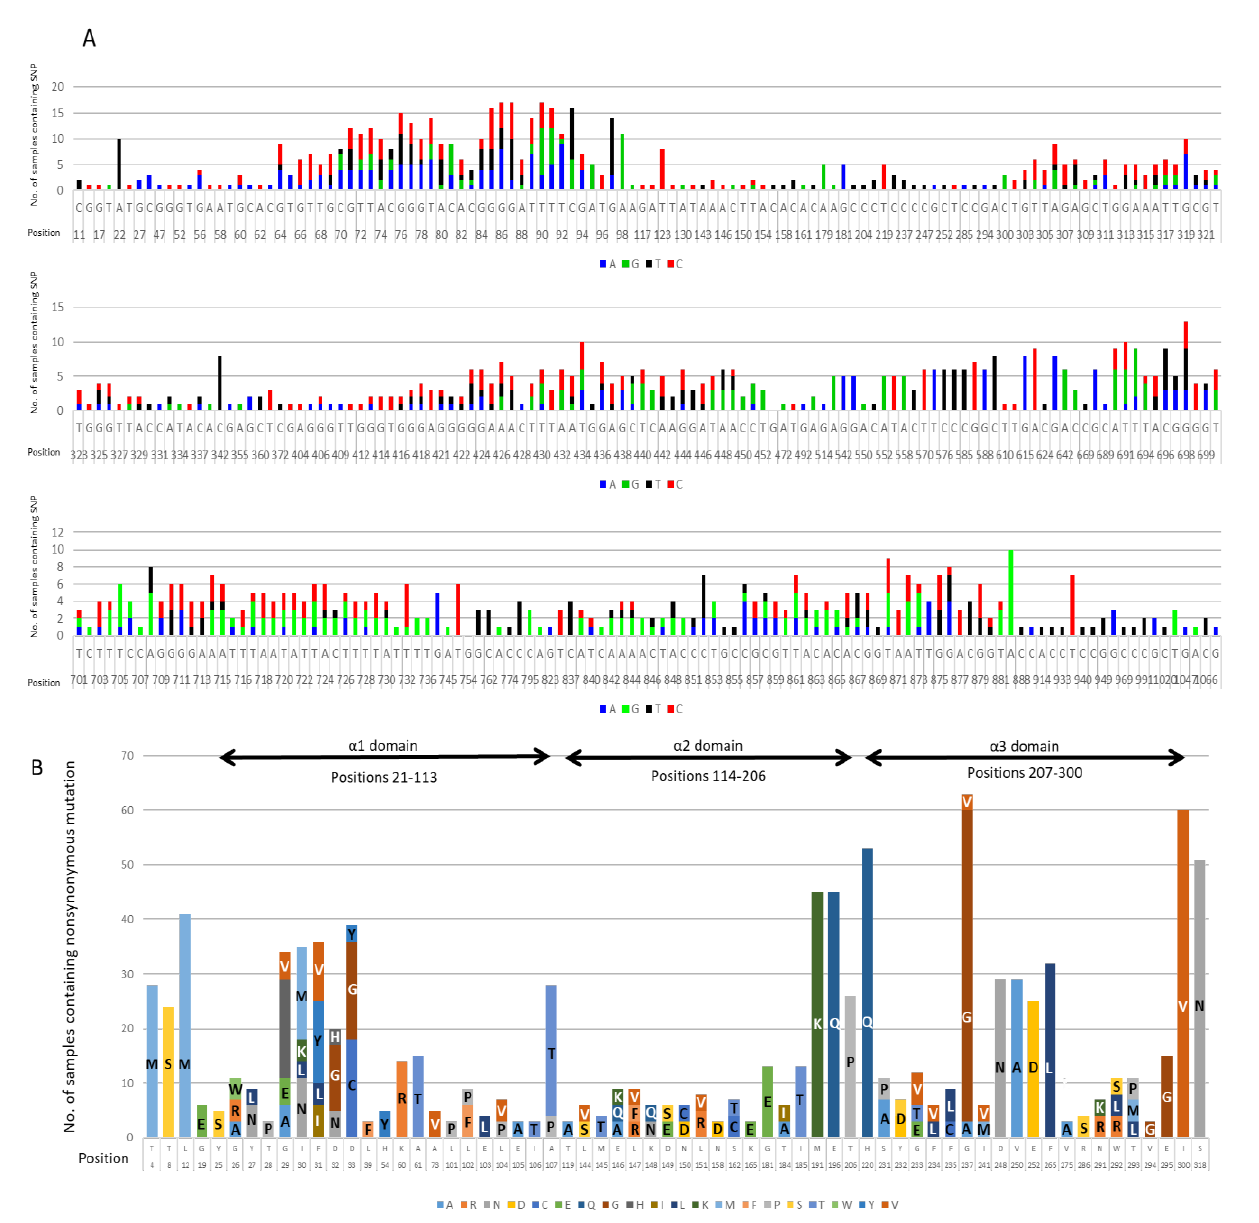
Figure 1. ( A ) All nucleotide variations identified in HCMV UL18 sequenced in 60 samples. Varia- tions are displayed in reference to HCMV Toledo. Blue bars represent A, green bars represent G, black bars represent T, and red bars represent C. ( B ) All nonsynonymous mutations identified in HCMV UL18 sequenced in 60 samples. Variations are displayed in reference to HCMV Toledo. Amino acids are represented by their one-letter codes. Each variation presented was found in at least 3